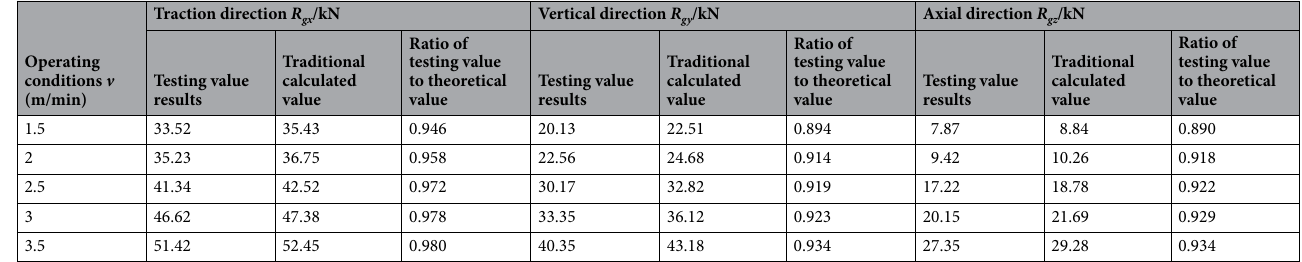
Table 3. Experimental results and conventionally calculated